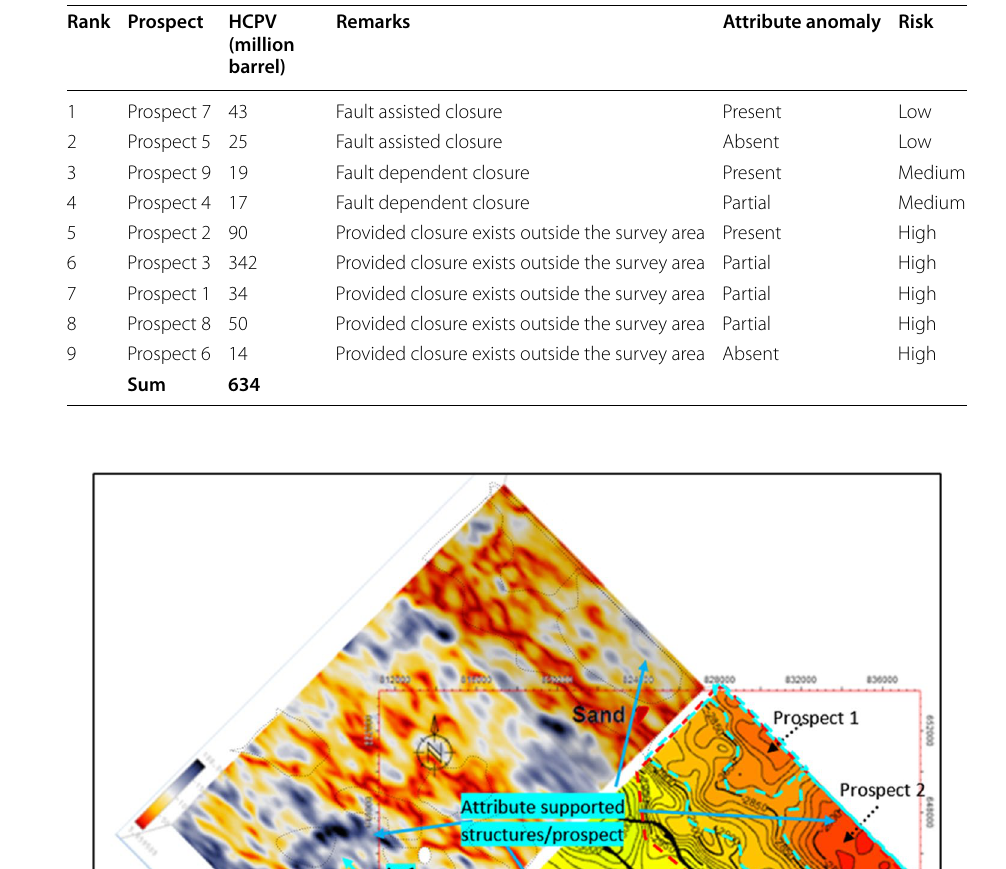
Table 2 Estimated reserves and ranking in Jay Field